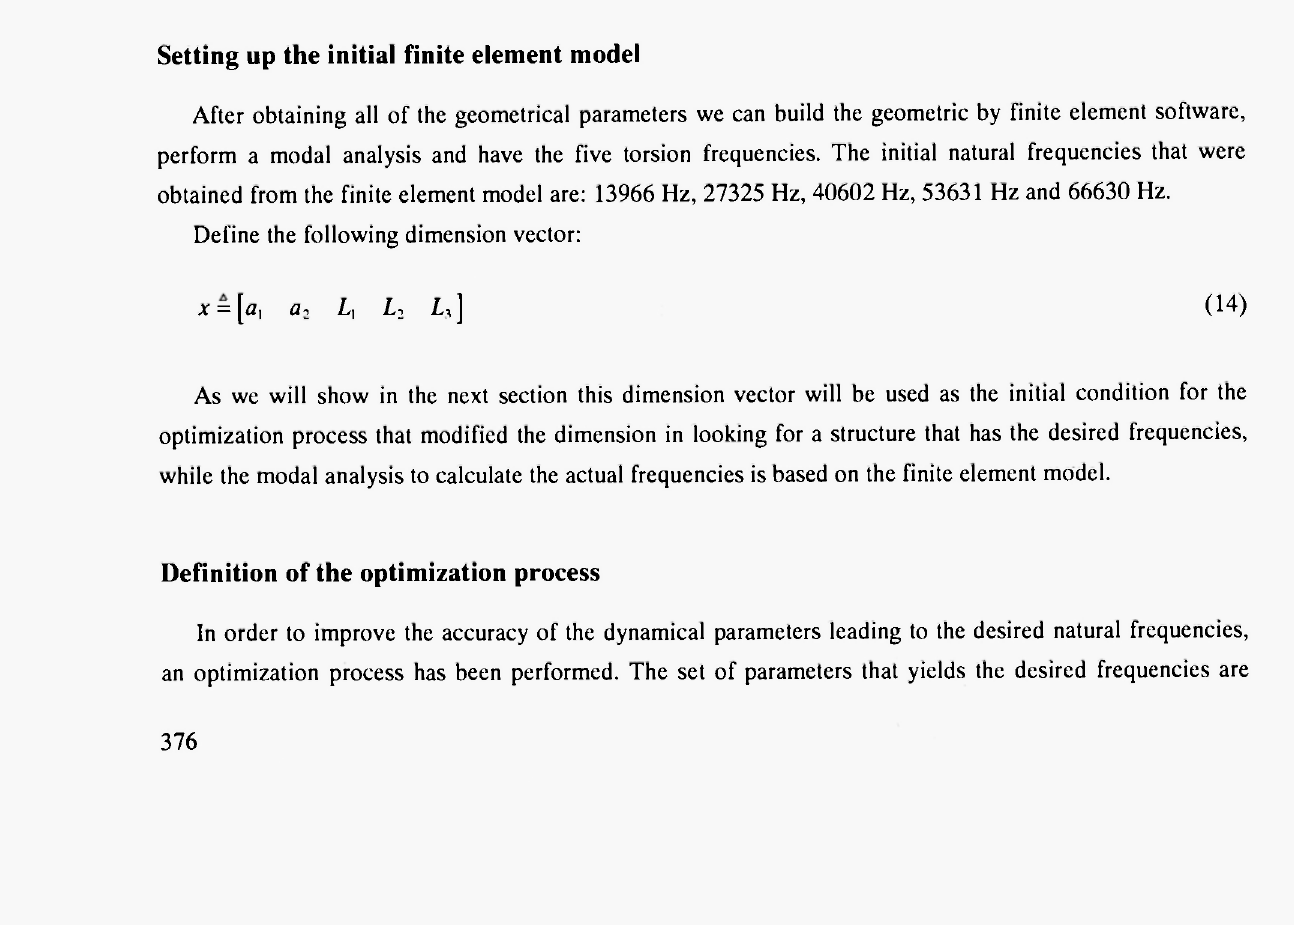
Initial values of the optimized